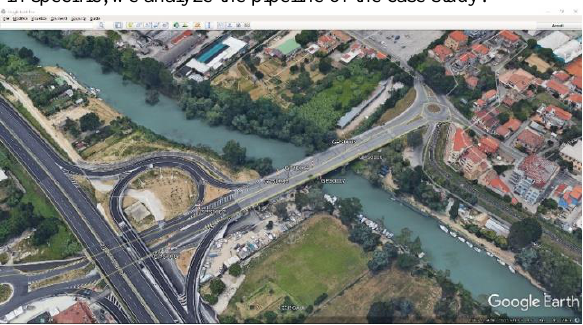
Figure 4: acquisition of 8 GPS certain points.